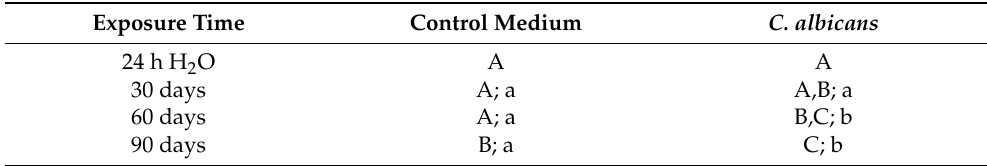
Table 2. The results of the Tukey’s HSD post hoc tests (columns) and t -student tests (rows) for the Vickers hardness.